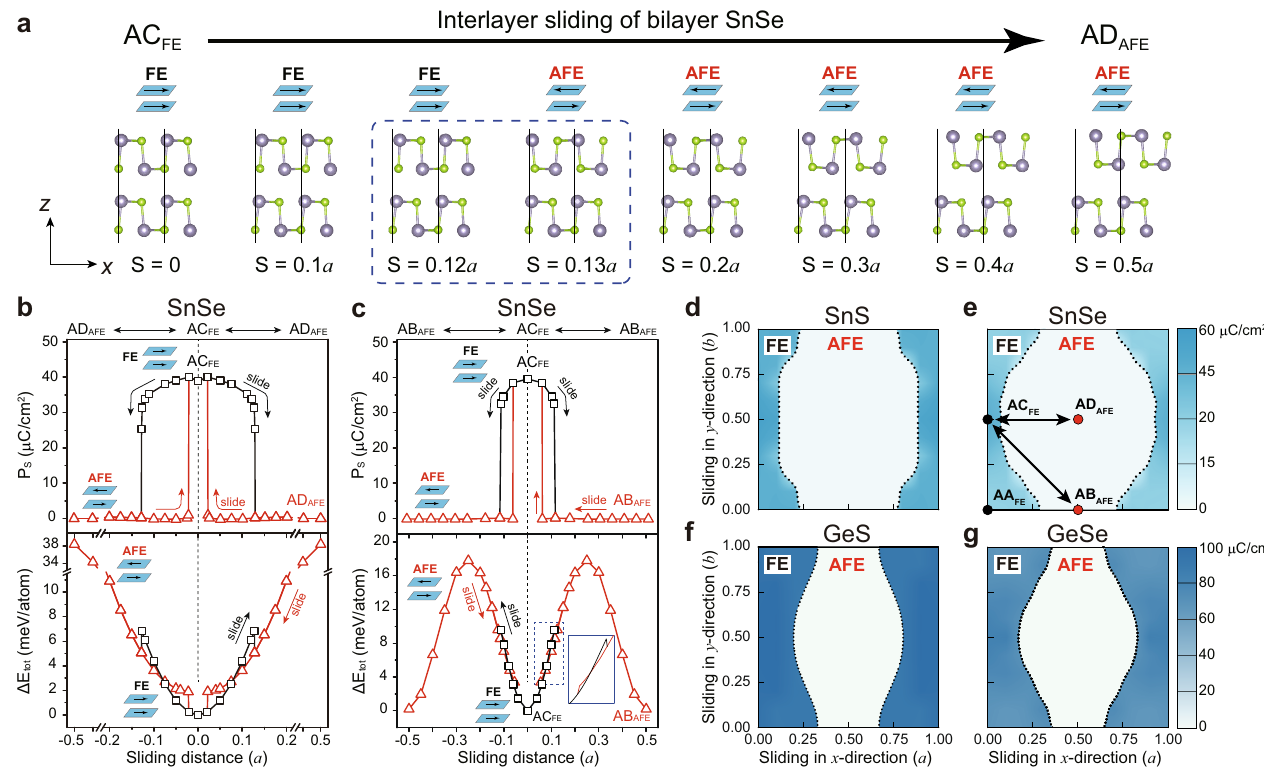
Fig. 2 FE-to-AFE phase transition upon tribological mechanical interlayer sliding. a The variation of atomic structures in the sliding process. b FE polarization P s and total energy difference as functions of the sliding distance (along the x -direction) of the top layer from the AC to the AD stacking order for bilayer SnSe. The sudden drop in the increase of P s at the critical sliding distance of 0.128 a or 0.021 a indicates the spontaneous FE-to-AFE or AFE-to-FE phase transition, respectively. A hysteresis loop can be observed, which is analogous to that of the traditional FE materials under external electric fi eld stimulus. At the two critical transition points, bilayer SnSe suddenly releases energy and transforms into the more stable phase. The energy crossing point is between the two critical points. c P s and total energy difference as functions of the sliding distance (along the diagonal direction in the x – y plane) from the AC stacking to the AB stacking. Similar phase transitions and hysteresis loop can be observed. A double-well-like curve due to the metastable AB stacking is shown (different from the unstable AD stacking). d – g Contour plots of P s as a function of the mechanical sliding distance (leading to different stacking orders) for SnS, SnSe, GeS, and GeSe, respectively. The color bar denotes the P s magnitude of bilayer MX . The black dotted lines represent the phase boundary between the FE and AFE states. The tribological mechanical sliding of the top layer across the boundary leads to the reversible FE-to-AFE phase transition, i.e., reversible switching of the FE polarization. This new phenomenon is here referred to as tribo induced FE-to-AFE